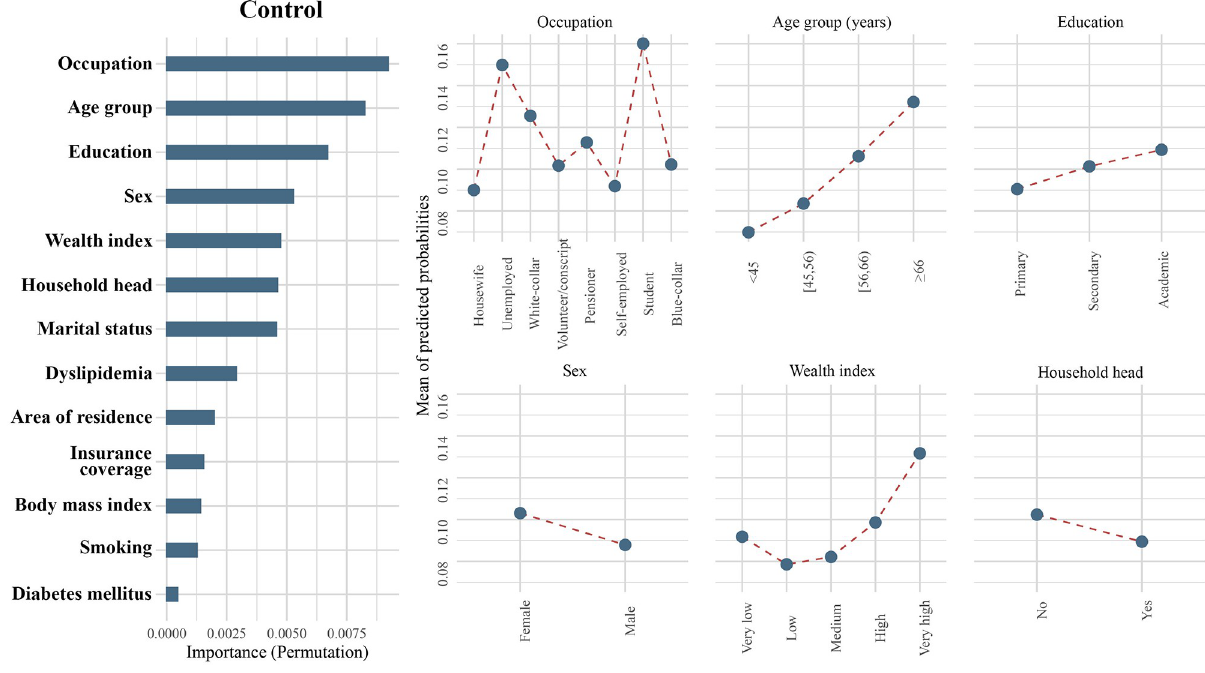
Fig 4. Importance of population characteristics and comparative probabilities of the top six important classifiers for control.